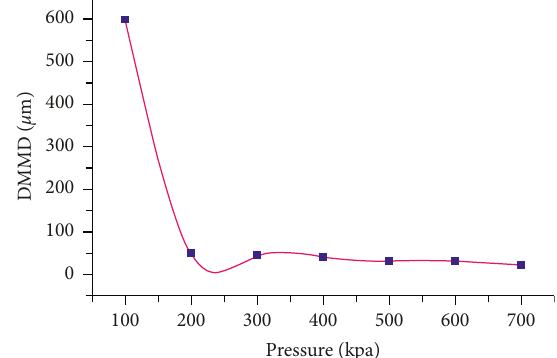
Figure 2: Dependence of the mass mean diameter and the stag- nation pressure of the air.